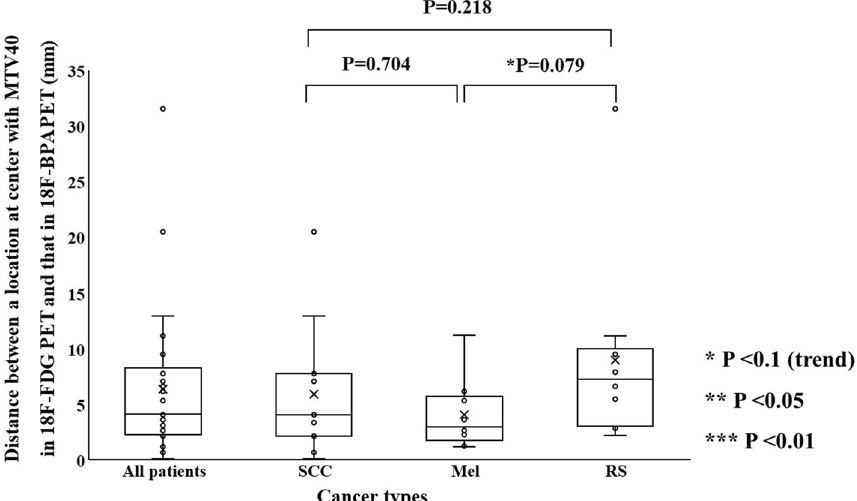
Fig. 8 The distances between locations at the center of mass with MTV40 between 18 F-FDG and 18 F-BPA PET for all patients, squamous cell carcinoma, melanoma, and